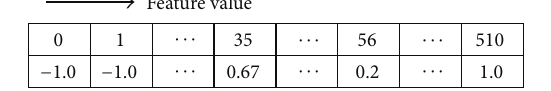
Figure 5: Example of weak classifier in the proposed